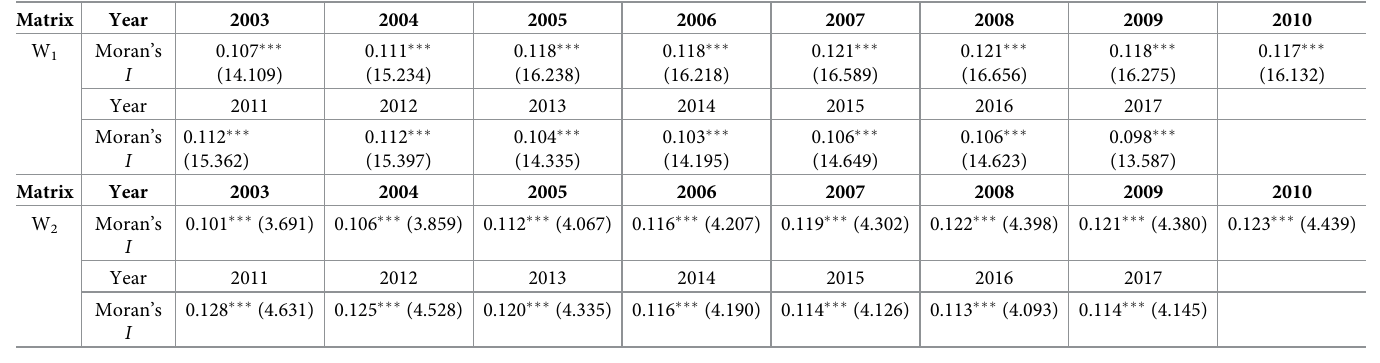
Table 8. Moran’s I under W 1 and W 2 weight matrixes.